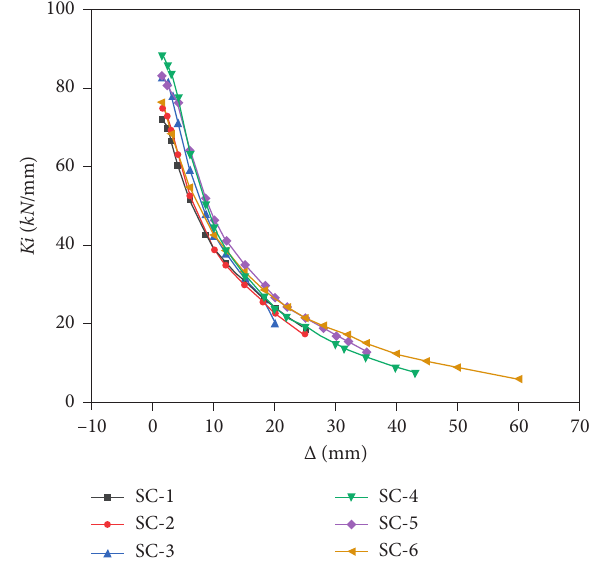
Figure 10: Stiffness degradation curves of specimens. Stiffness degradation of the specimens is represented by secant stiffness K